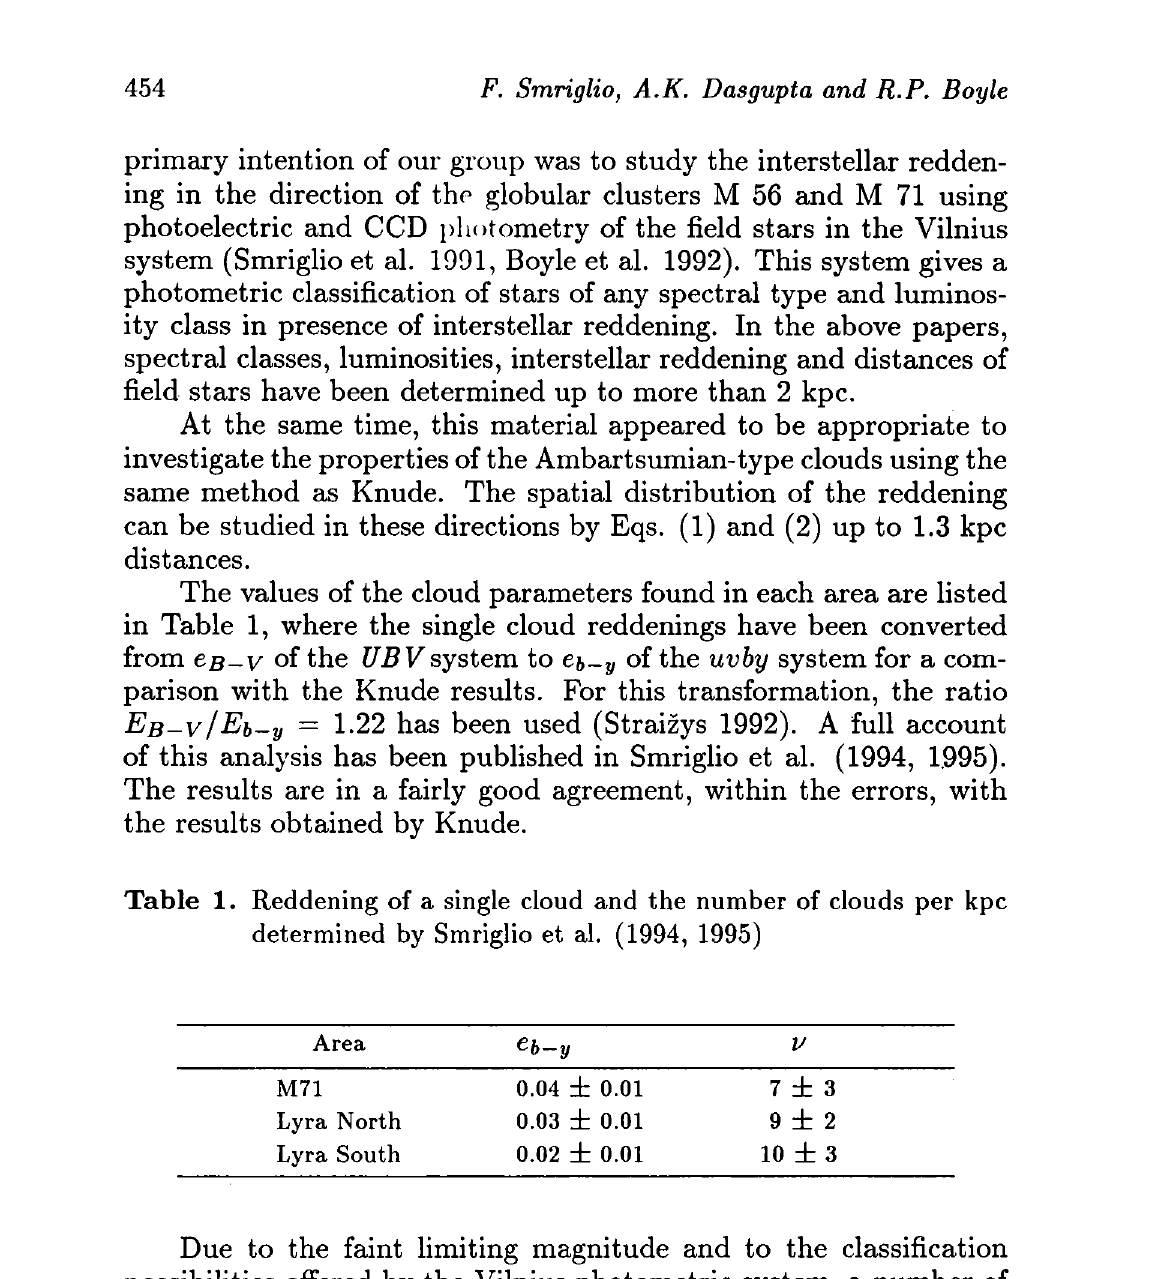
Table 1. Reddening of a single cloud and the number of clouds per kpc determined by Smriglio et al. (1994,